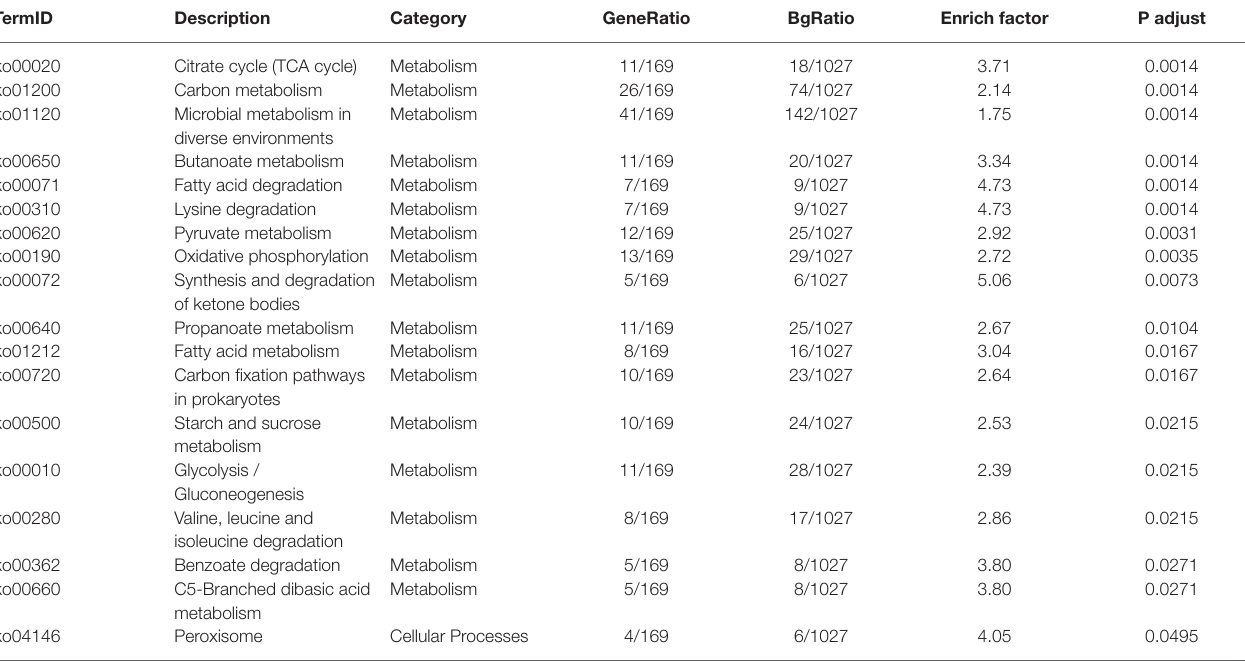
TABLE 2 | KEGG enrichment analysis of B. amyloliquefaciens in paired comparison of Gm-Ba-Ss vs.